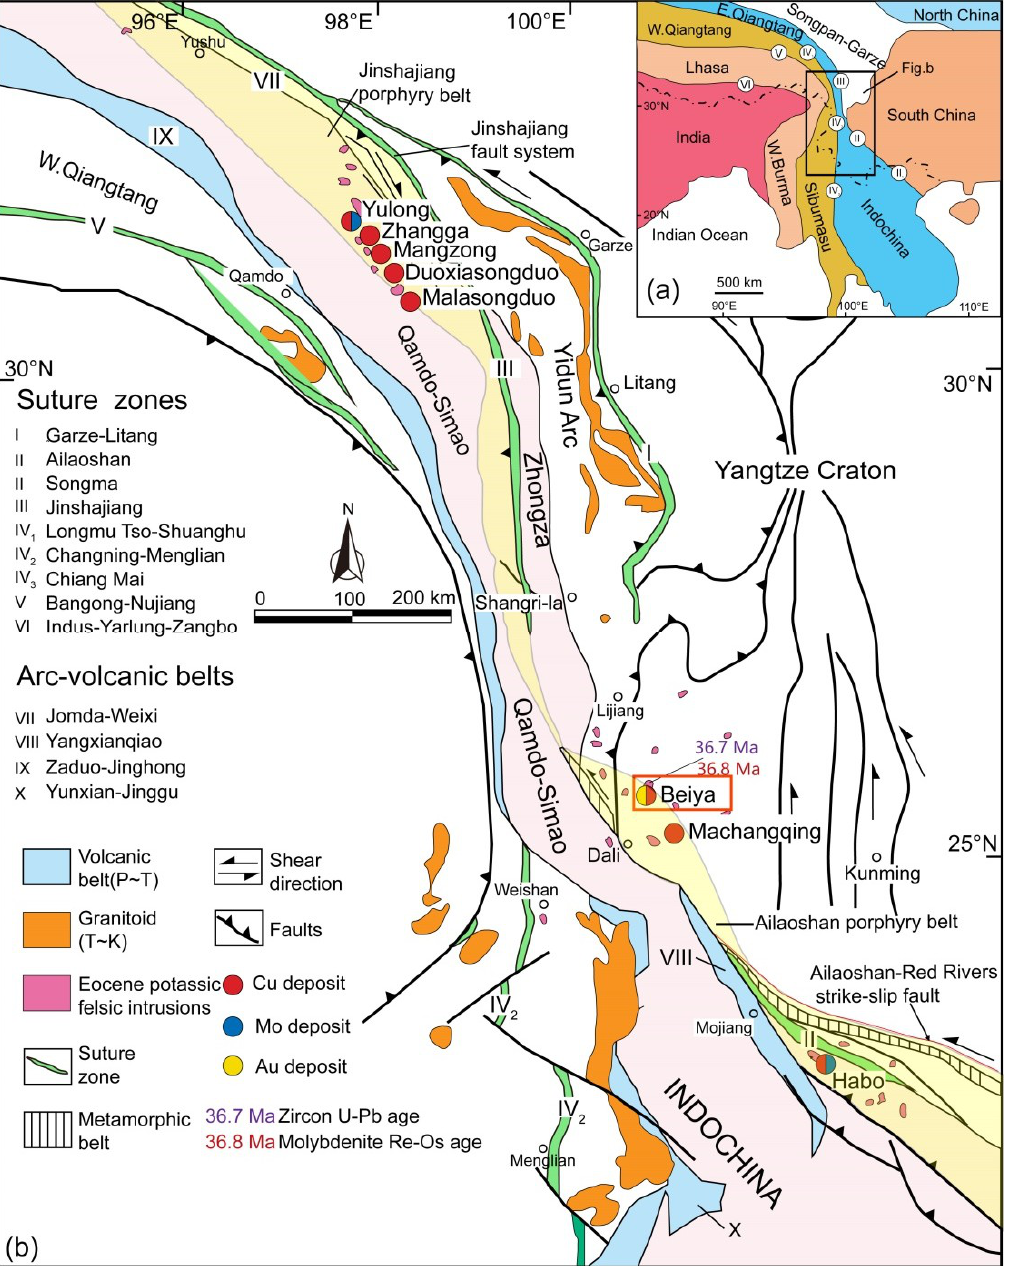
Figure 1. Regional tectonics of the Jinshajiang-Ailaoshan alkaline porphyry belt showing the distribution of Cenozoic deposits [17].